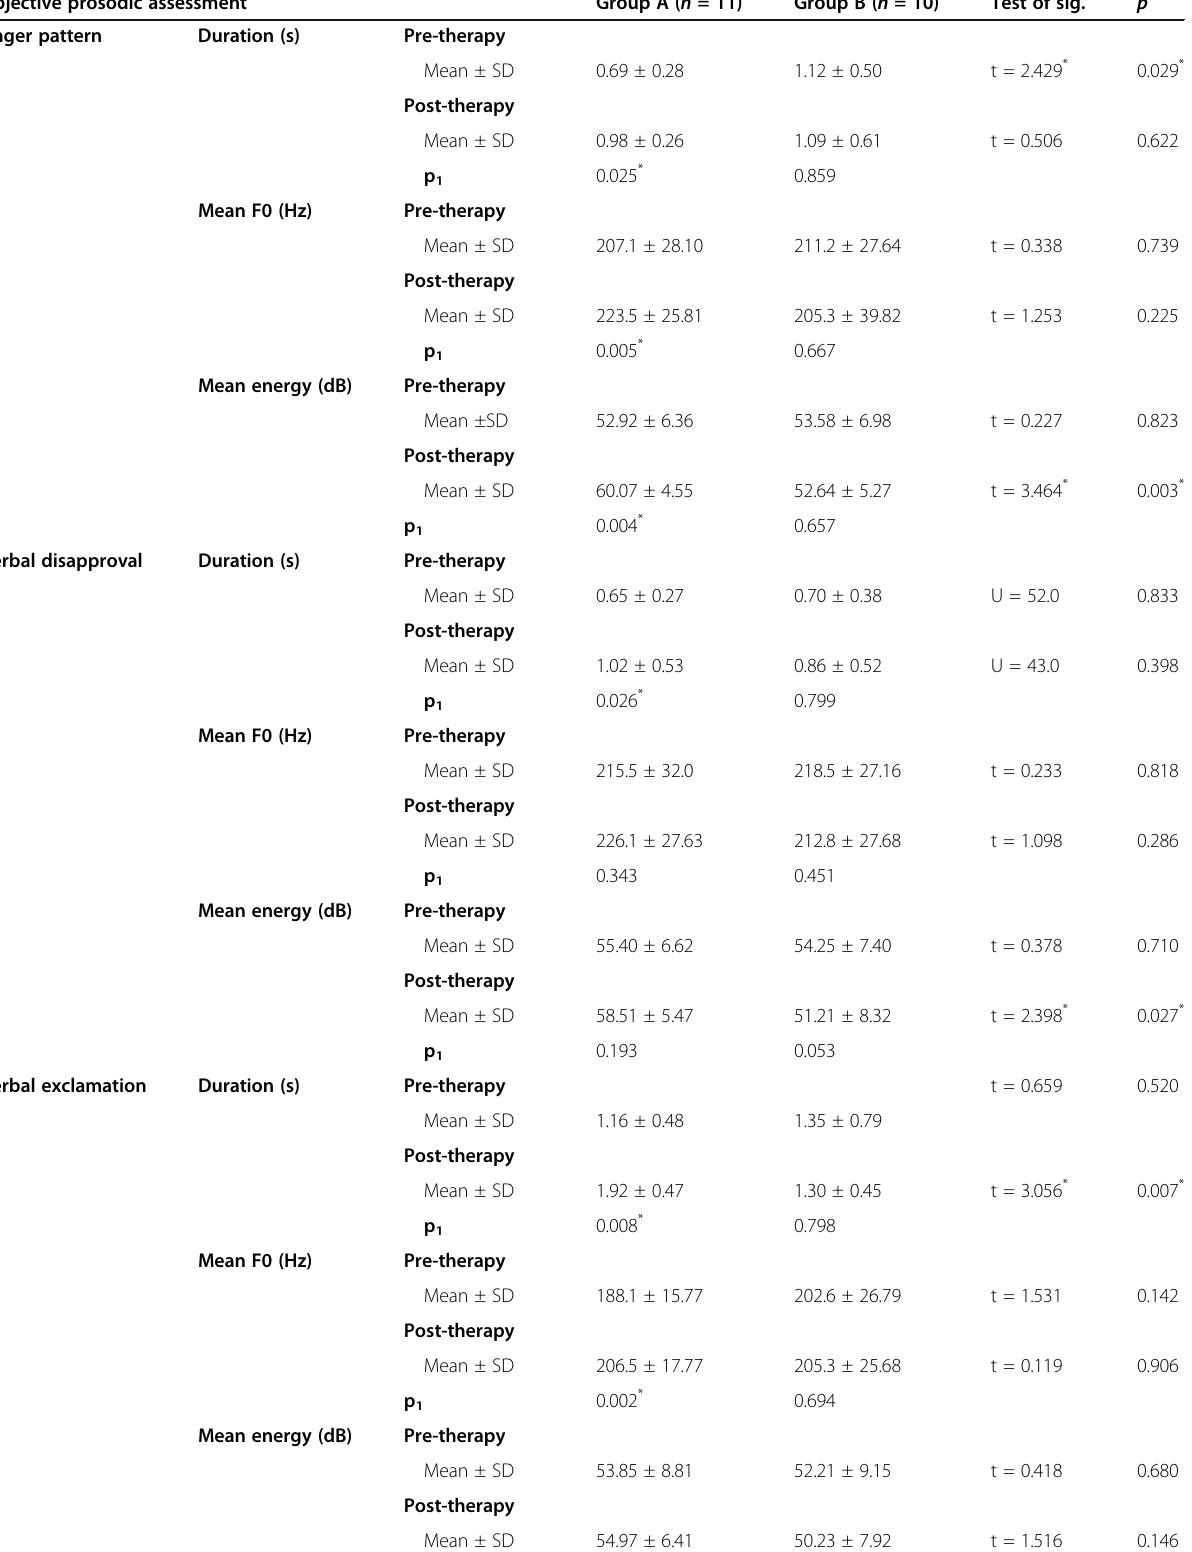
Table 6 Comparison between the two studied groups according to objective prosodic assessment Objective prosodic